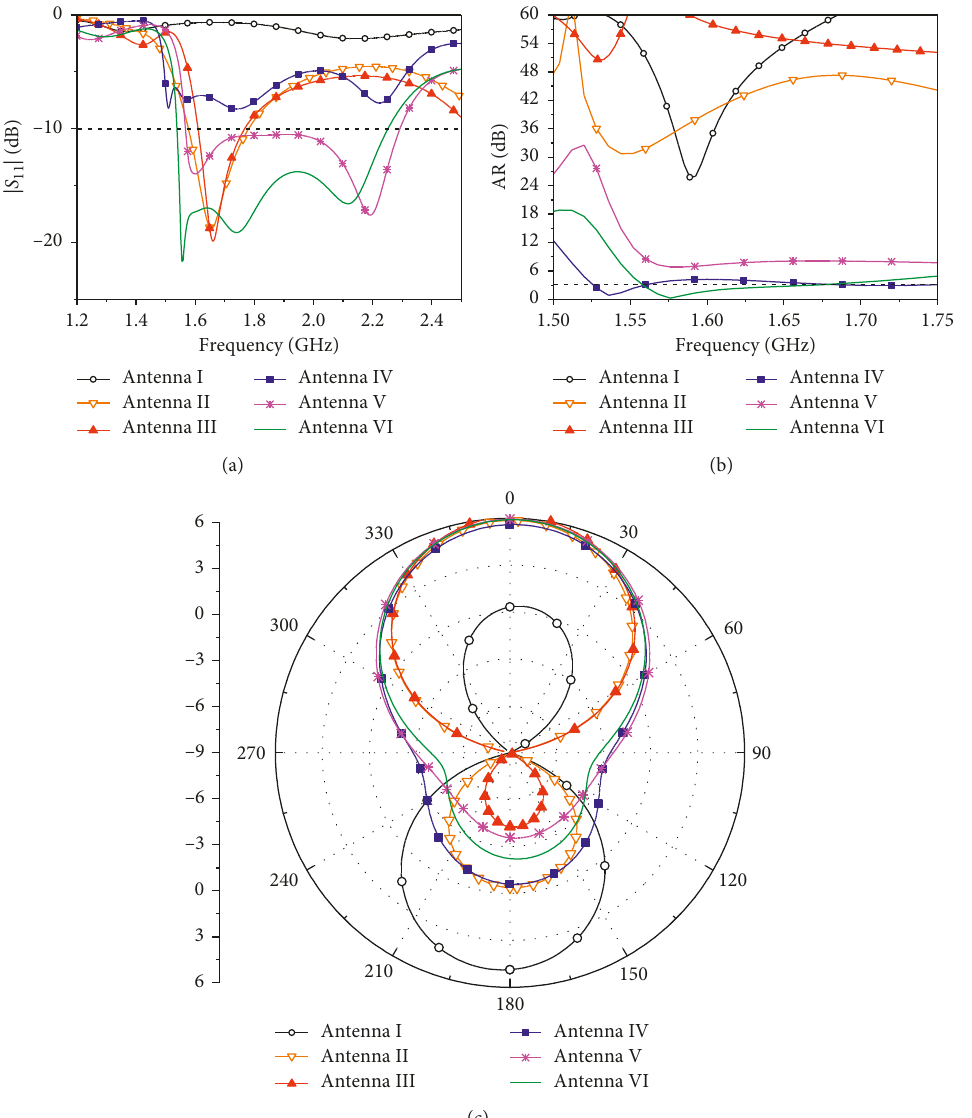
Figure 3: Simulated reflection coefficient | S 11 | and axial ratio of Antennas I–VI. (a) | S 11 |, (b) axial ration, and (c) radiation